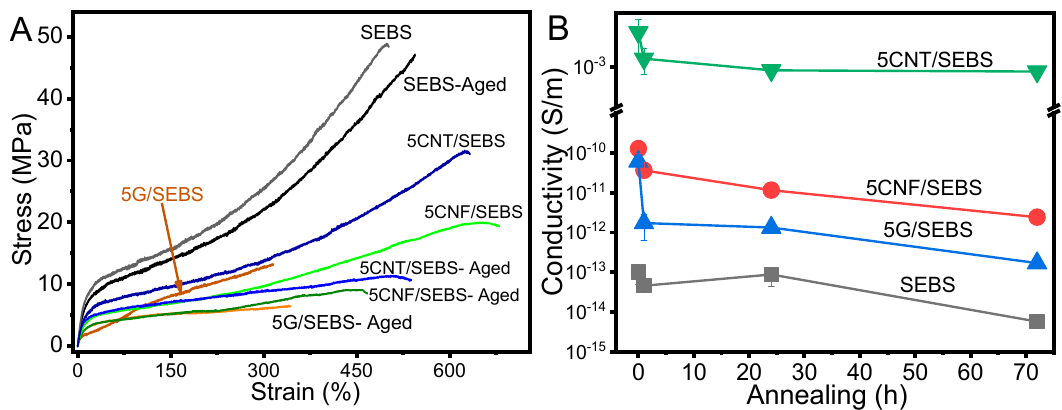
Figure 8. ( A ) Mechanical properties of SEBS and its composites with 5 wt.% of different fillers (graphene, CNF, and CNT) at 5 mm/min before and after annealing for 72 h at 120 °C; ( B ) Electrical conductivity for SEBS and respective nanocomposites with 5 wt.% filler content for the different annealing times at 120 °C.